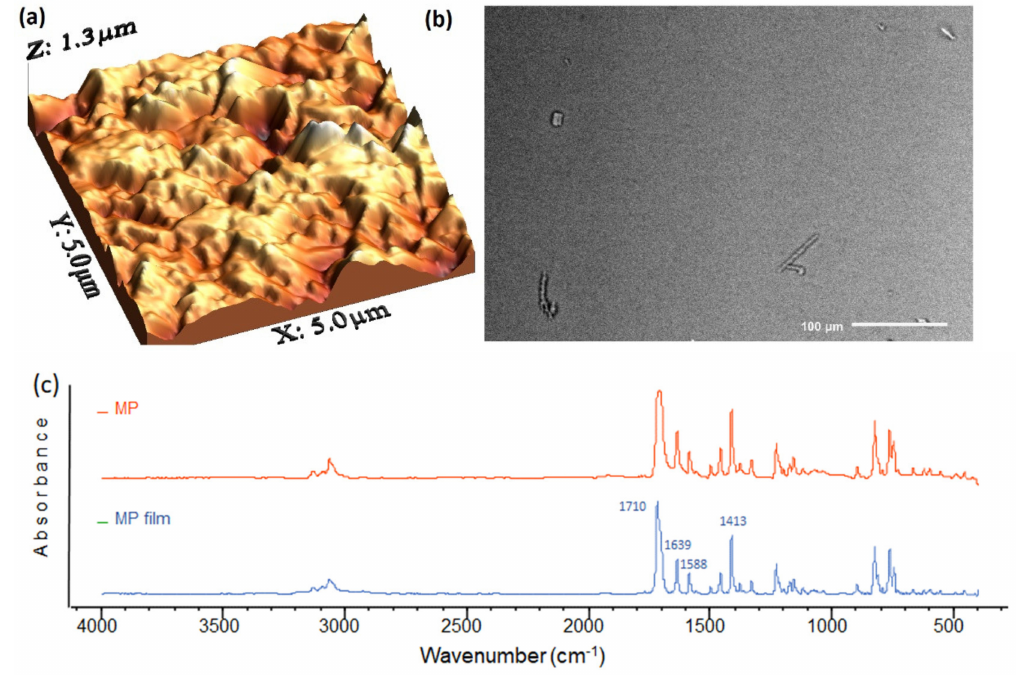
Figure 2. ( a ) AFM image, ( b ) SEM image and ( c ) IR spectrum for the pristine film of